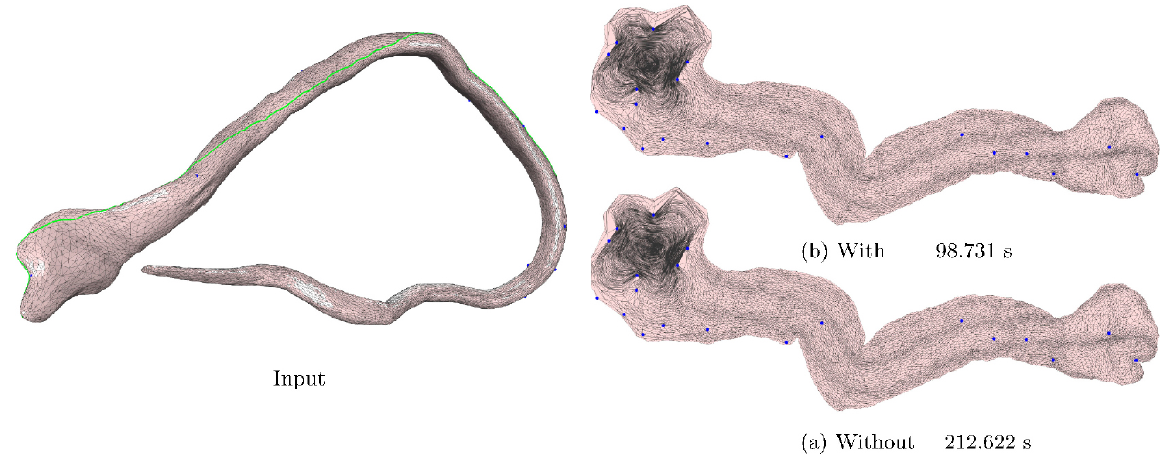
Fig. 6 Distance reduction step. Results without (a) and with (b) the distance reduction step, for the same positional